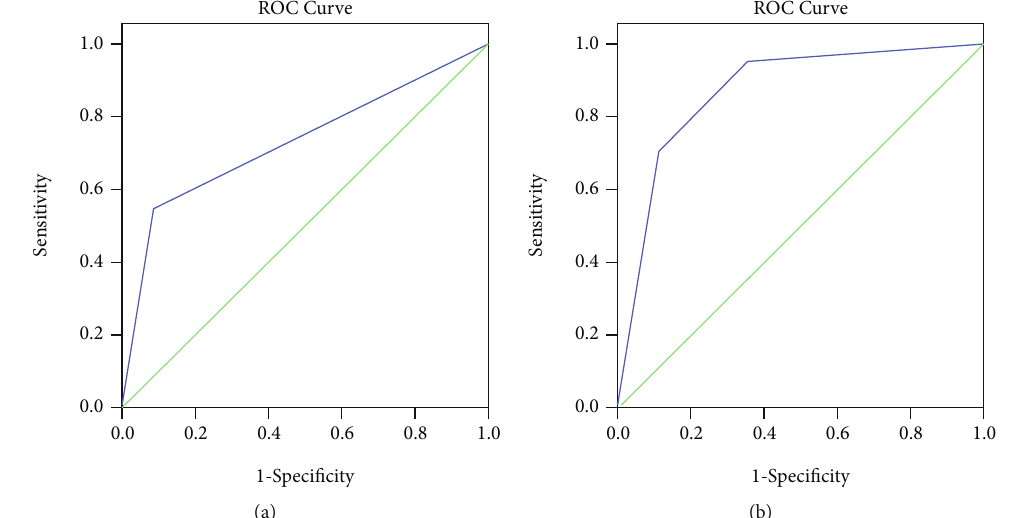
Figure 1: ROC curve analysis of two scoring methods to diagnose gastric cancer. (a) ROC curve analysis of Chinese new gastric cancer screening score (i.e., Li ’ s score). (b) ROC curve analysis of Kyoto Classi fi cation of